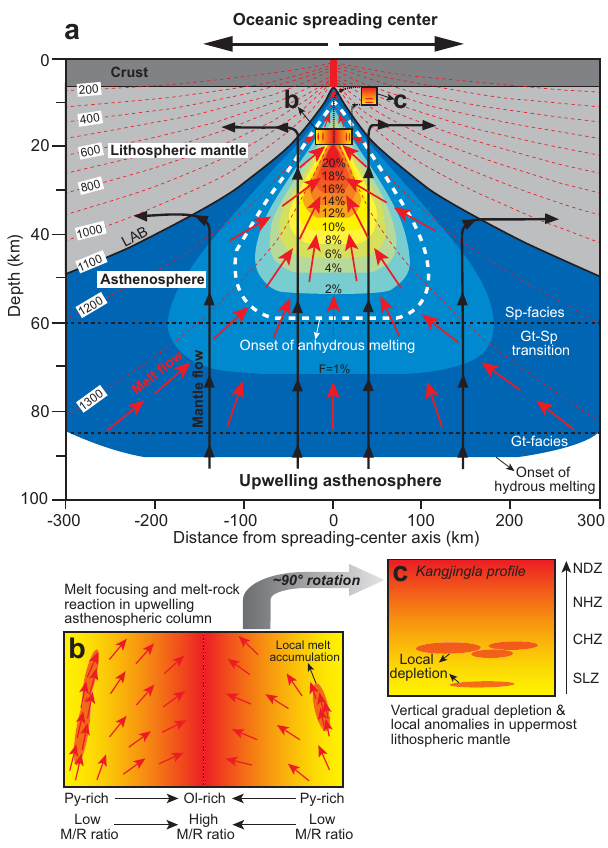
Fig. 6 | Schematic cartoons (a-c) illustrate melt focusing and melt-peridotite interaction in the upwelling asthenospheric column under a typical oceanic spreading center. Panel a shows a vertical cut plane (100km deep and 600km wide) of a sub-spreading-center regime far from transform faults, modi fi ed from Ligiet al. 7 . Lithospherespreading and asthenosphere upwelling produce the color- codeddecompressionalmeltingregionswithmeltingdegrees(F)of1 – 20%marked ( a ).Reddashedcurveswithtemperaturesfrom1300°Cto200°Cshowthethermal structureofthelithosphereandasthenosphere 7,9,10,42 ,andthe1100°Ccurvemarks the lithosphere-asthenosphere boundary (LAB) as proposed by Niu and Green 43 . Two black dashed lines show the boundaries between spinel- and garnet-facies mantle and the garnet-spinel transitional zone (85 – 60km) in between. The white dashed curve encloses the upwelling asthenospheric mantle where anhydrous melting occurs. The red short arrows show that the melts converge and focus into the sub-axis narrow zone under the spreading center. The black thick curves with black arrows display the fl ow patterns of upwelling asthenosphere. The residual mantle columns represented by the color-coded zones have the compositional gradients too small to be consistent with the Kangjinla situation (Figs. 2 – 4). A modelofmeltfocusingandmelt-rockreaction(pyroxeneconsumptionandolivine addition) in the top region of the upwelling asthenospheric column ( b ) can well explain the vertical depletion and local depleted anomalies displayed in ( c ). The variations of melt/rock (M/R) ratios in the column result in the lithological and compositionalvariations, which form the laterally symmetrical mantlecolumn ( b ). After it splits into two parts which each rotates ~90° to become the oceanic uppermostlithosphericmantle,theprimarilymore-depletedaxialregionformsthe top of the lithospheric mantle section while the more-fertile bilateral region becomes the bottom ( c ), as observed in the Kangjinla and other ophiolites. Sp spinel, Gt garnet, Py pyroxene, Ol olivine, NDZ northern dunite zone,